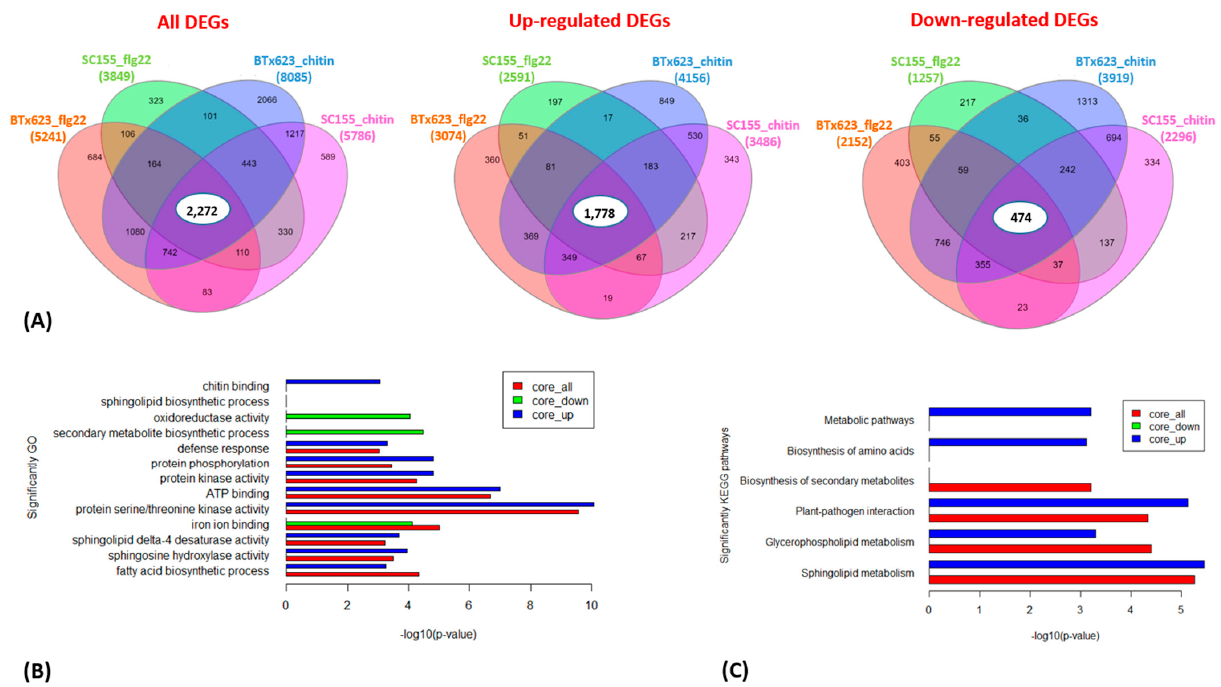
Figure 4. ( A ) Venn diagrams showing the numbers of overlapping and non-overlapping MAMP-responsive genes between BTx623 and SC155-14E at p = 0.001. The total, up-regulated and down-regulated DEGs and the treatments are indicated. The numbers of total, up- and down-regulated core DEGs are highlighted in the middle. ( B ) Enriched gene ontology (GO) terms associated with core sets of total, up- and down-regulated DEGs in flg22 or chitin treated BTx623 and SC155-14E were shown with p -values indicated on x-axes. ( C ) Enriched KEGG pathways of the total, up- and down-regulated core DEGs in flg22 or chitin treated BTx623 and SC155-14E with p -values indicated on x-axes.